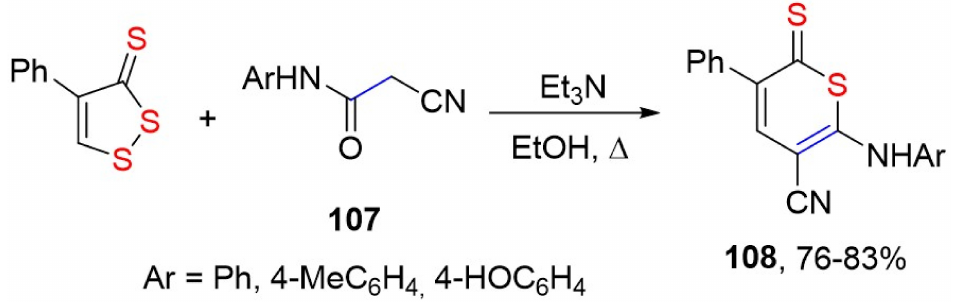
Scheme 61. Synthesis of 2 H -thiopyran-2-thiones 108